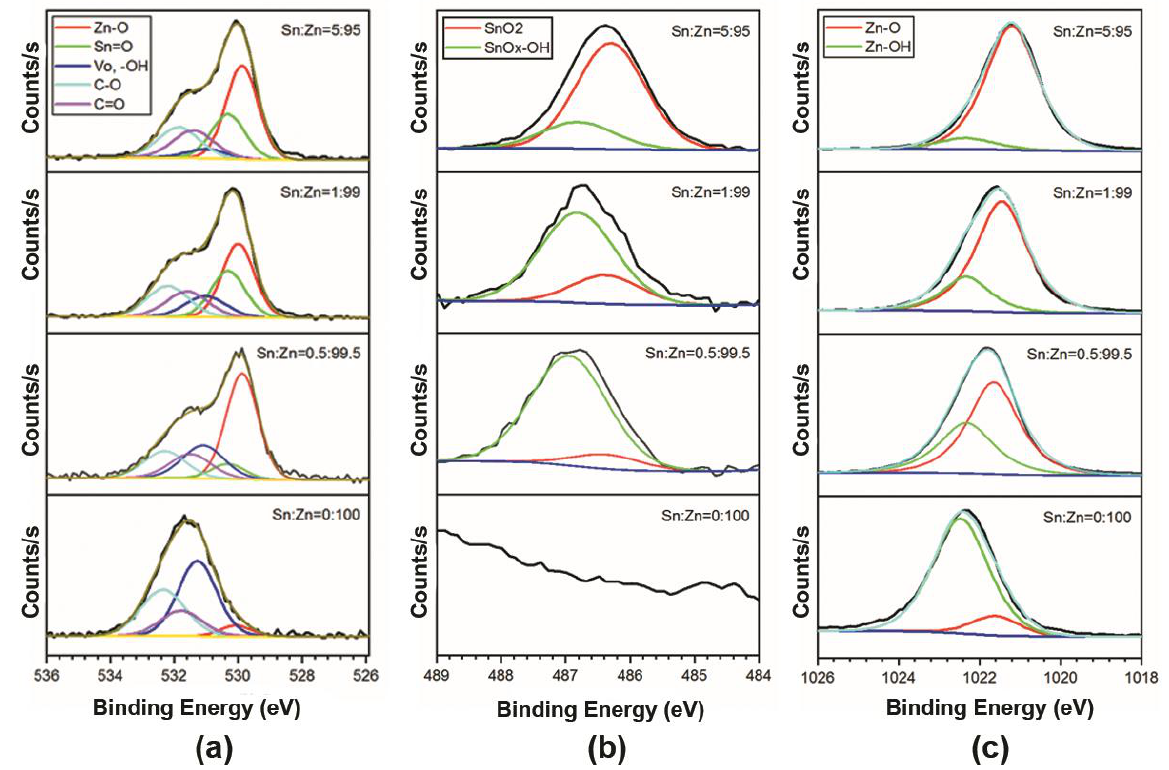
Figure 8. High-resolution spectra of thin ZnO-SnO 2 films materials ZnO, Sn:Zn = 0.5:99.5, Sn:Zn = 1:99, Sn:Zn = 5:95. High-resolution spectra of O 1s ( a ), Sn 3d 5/2 ( b ), Zn 2p 3/2 ( c ). Table 2. The values of the components binding energies for the photoelectron lines of O 1s in zinc and tin oxides. Bond, eV